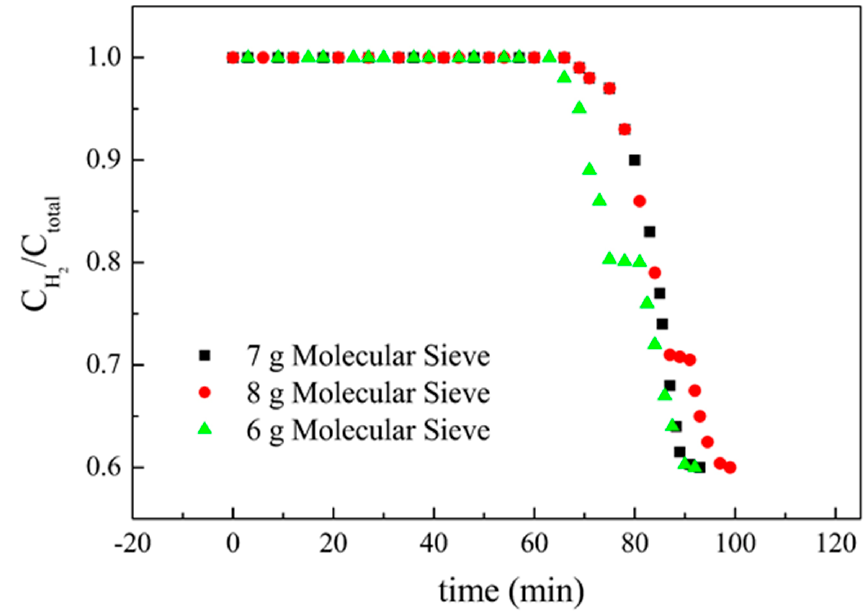
Figure 10. The effect of the addition of molecular sieve on the ratio of hydrogen concentration to the total concentration of gas.